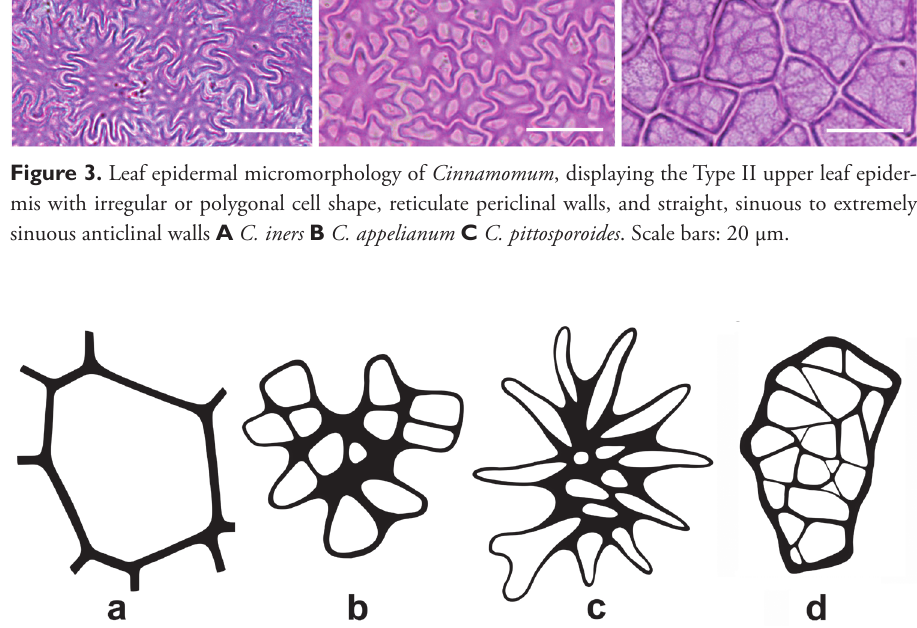
Figure 4. Line-drawing displaying variation of the leaf upper epidermis a type I, displaying the non-re- ticulate periclinal wall, the polygonal cells, and the round to polygonal cell shape b type II, displaying the sinuous anticlinal wall, the irregular cell shape, and the reticulate periclinal wall c type II, displaying an extremely sinuous anticlinal wall, the irregular cell shape, and the reticulate periclinal wall d type II, dis- playing the straight or nearly so anticlinal wall, the polygonal cell shape, and the reticulate periclinal